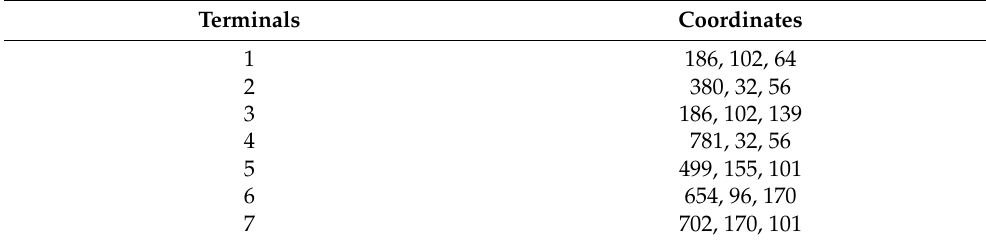
Table 2. Coordinates of the terminals of the 1st